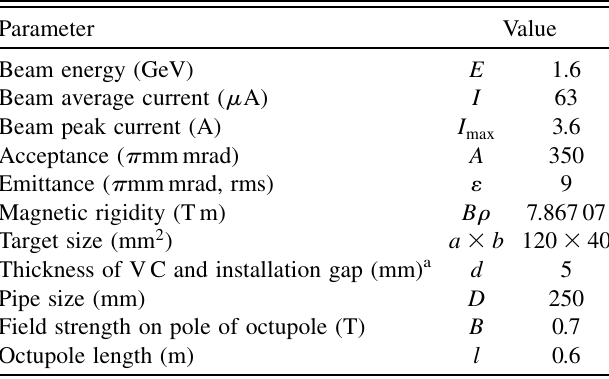
TABLE I. The CSNS RTBT parameters.